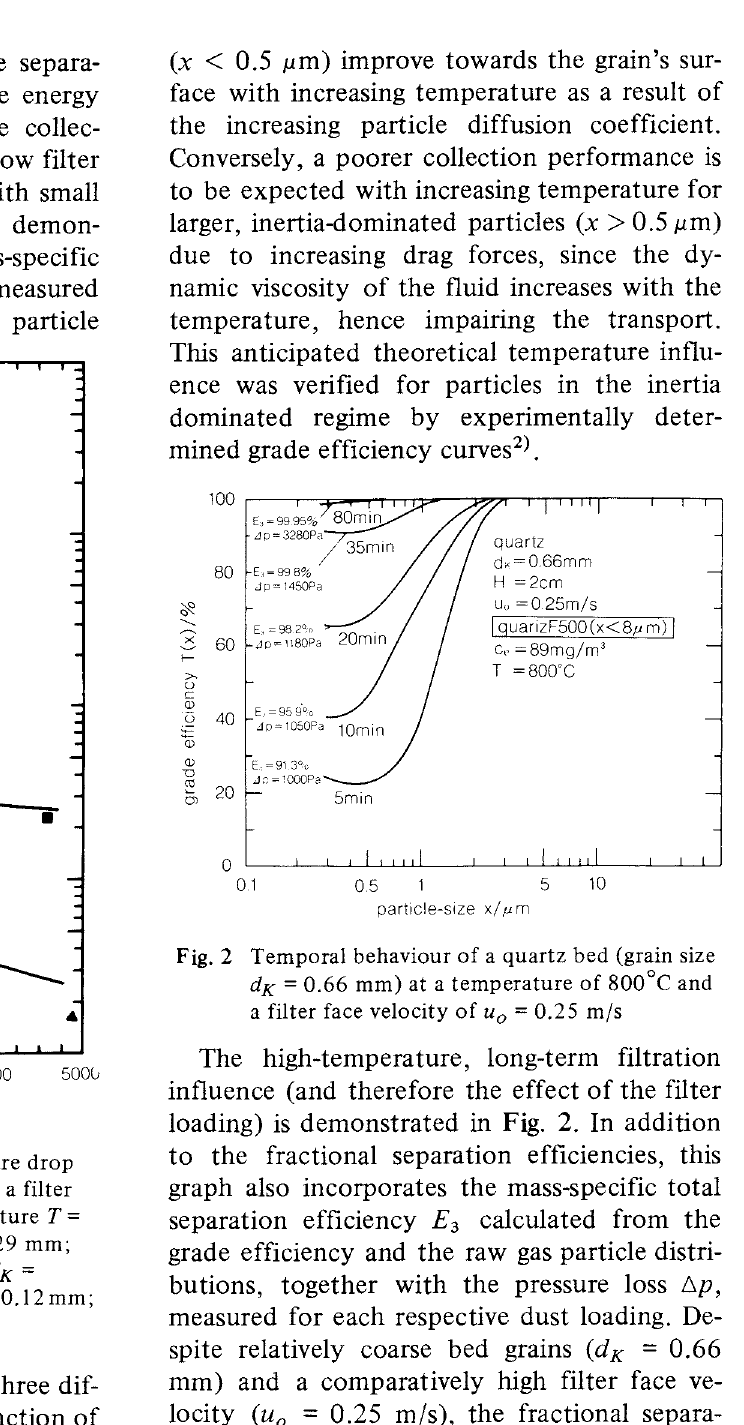
Fig. 1 Penetration as a function of the pressure drop for three grain fractions (limestone) at a filter face velocity of u = 0.1 m/s (temperature T = 0 20°C). Fraction 1: 10 mass-% dK = 0.29 mm; 90 mass-% dK = 0.7 mm; Fraction 2: dK = 0.29 mm; Fraction 3: 10 mass-% dK = 0.12mm; 90 mass-% dK = 0.29 mm